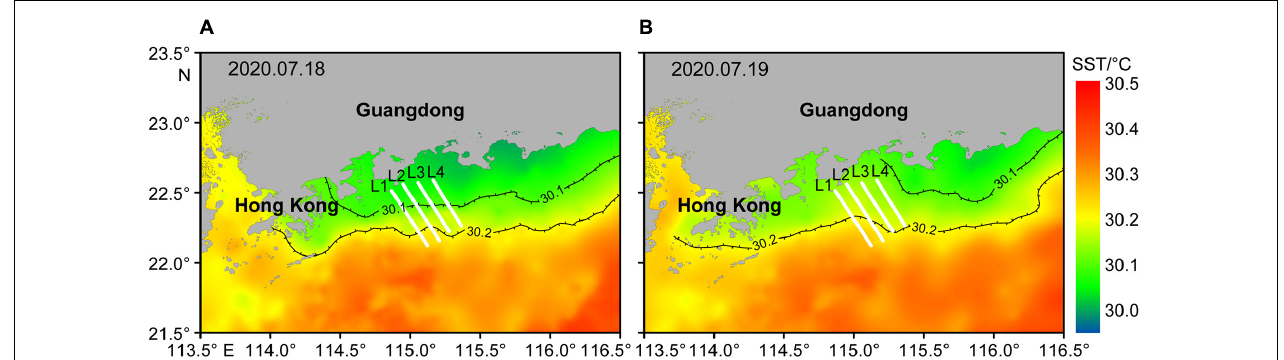
FIGURE 10 | The satellite-composite sea surface temperature (SST) on July 18, 2020 (A) and July 19, 2020 (B) indicates that the study area was influenced by coastal cold water upwelling. The black lines with half ticks represent the transition zone (30.1 ◦ C < SST < 30.2 ◦ C) and upwelling zone (SST < 30.1 ◦ C). The white lines denote the acoustic backscatter survey lines.